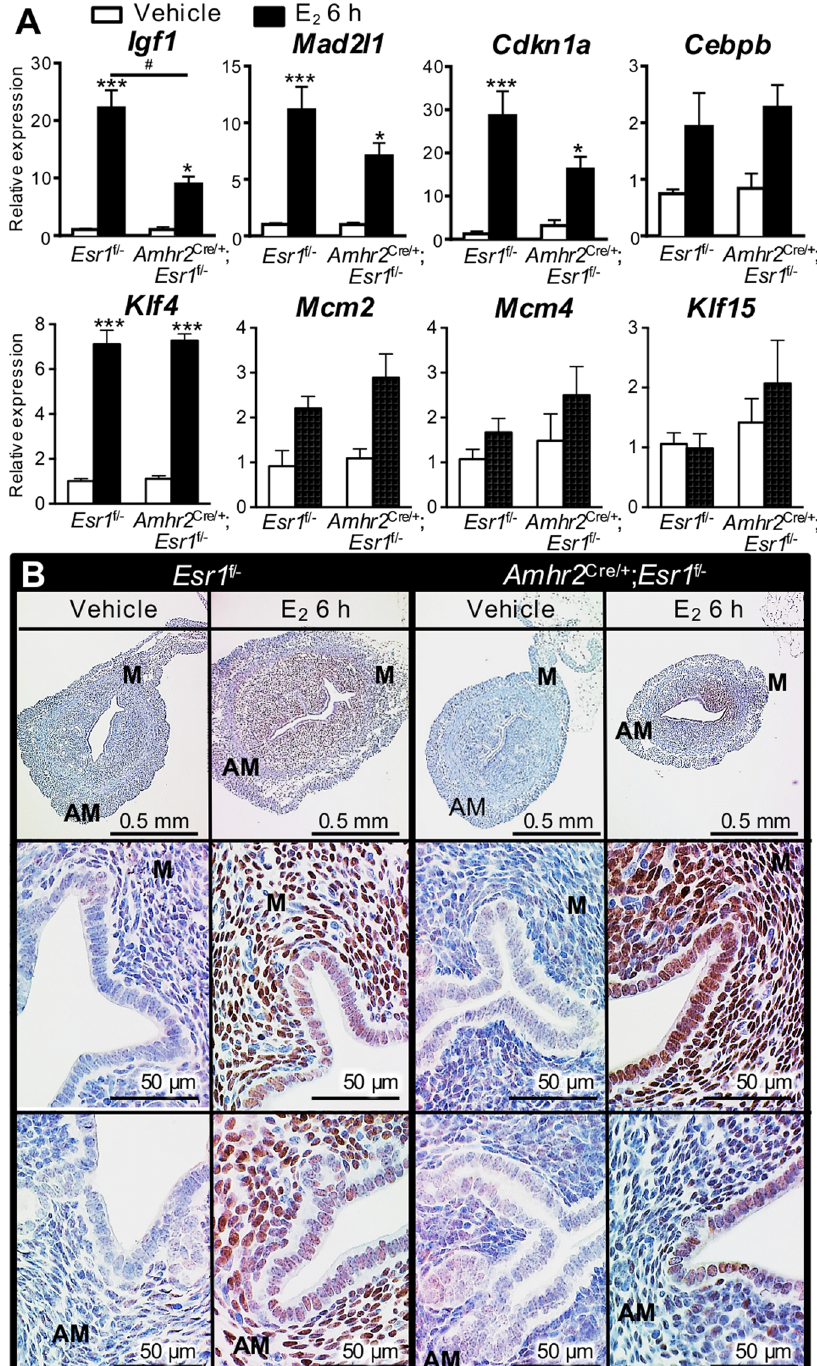
Figure 3. Cell proliferation-related uterine transcripts and protein in ovariectomized 8–12-week-old Esr1 f/ − and Amhr2 Cre/ + ; Esr1 f/ − females treated with E 2 for 6 h. ( A ) Real-time PCR was performed and the relative expression values of Igf1 , Mad2l1 , Cdkn1a , Cebpb , Klf4 , Mcm2 , Mcm4 , and Klf15 were normalized to Rpl7 . * , *** p < 0.05, 0.001; significant difference between vehicle and E 2 treated samples within genotype. # p < 0.05; significant difference between E 2 treated samples between genotype; unpaired t- test. ( B ) CEBPB protein expression after 6 h of E 2 treatment in Esr1 f/ − and Amhr2 Cre/ + ; Esr1 f/ − uteri using IHC analysis. All graphs represent mean ± SEM. N = 3–5 mice/genotype/treatment. M = Mesometrium, AM = Anti-mesometrium. Representative images